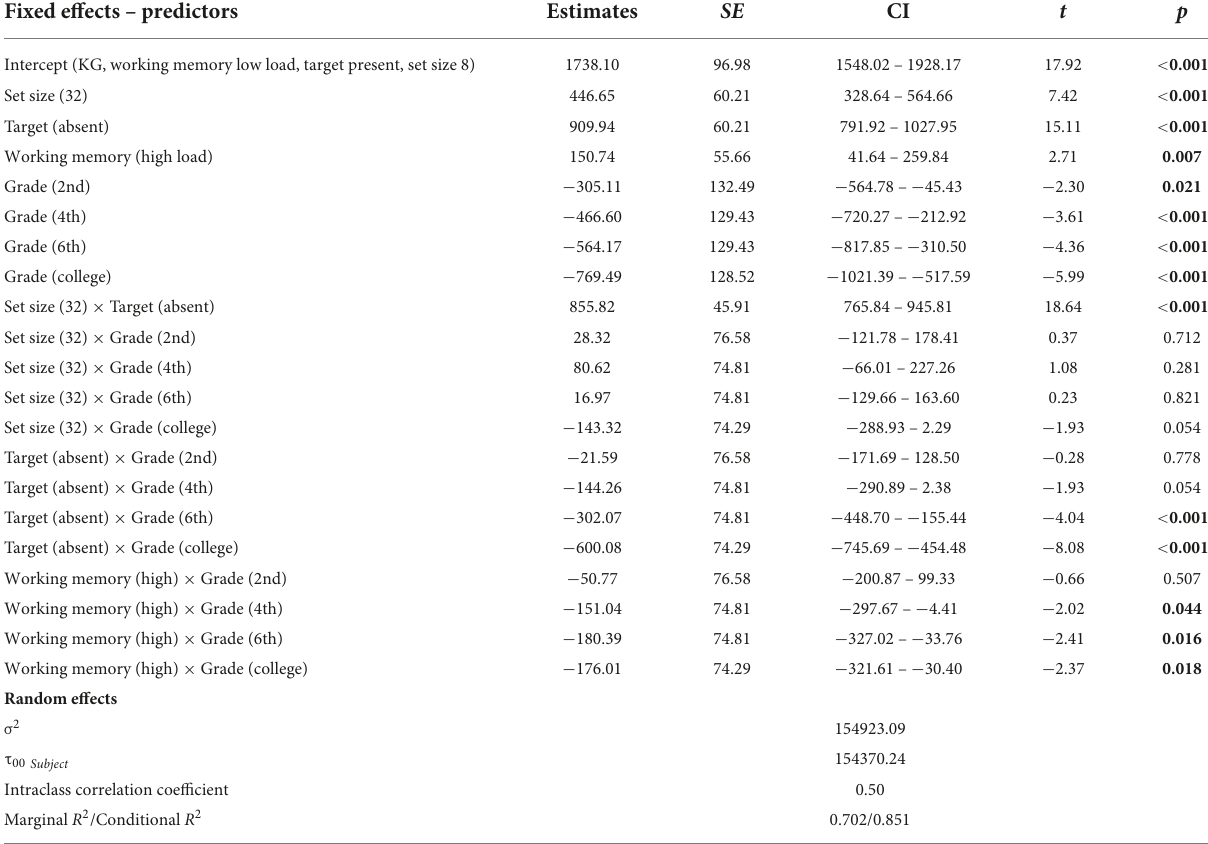
TABLE 4 Estimated coefficients for reaction times in the visual search task. Fixed effects – predictors